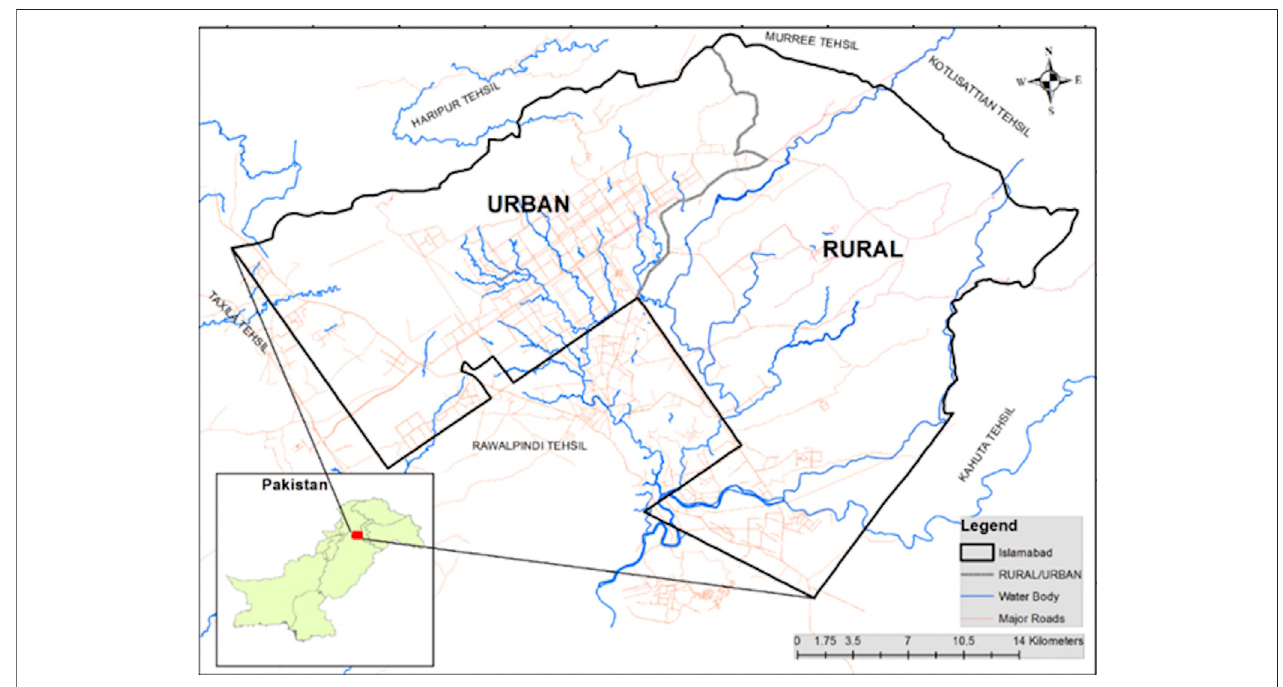
FIGURE 1 | Geographical location of the study area along with boundaries and water bodies (Islamabad).